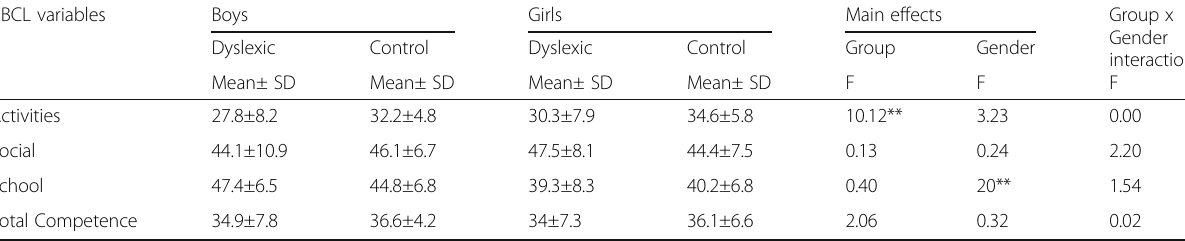
Table 5 Gender effect on competence scale scores of CBCL among dyslexic and control groups CBCL variables Boys